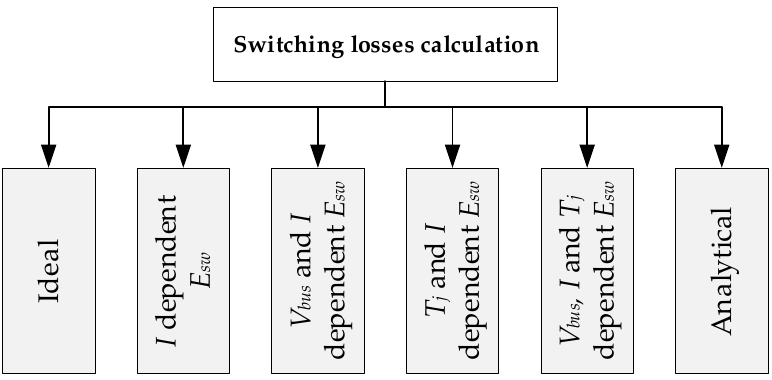
Figure 8. The considered six switching power losses calculation variants.